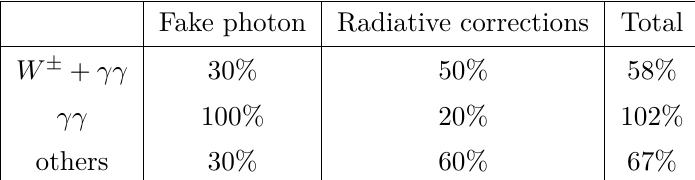
Table 2 . Systematic uncertainties on the background estimates.